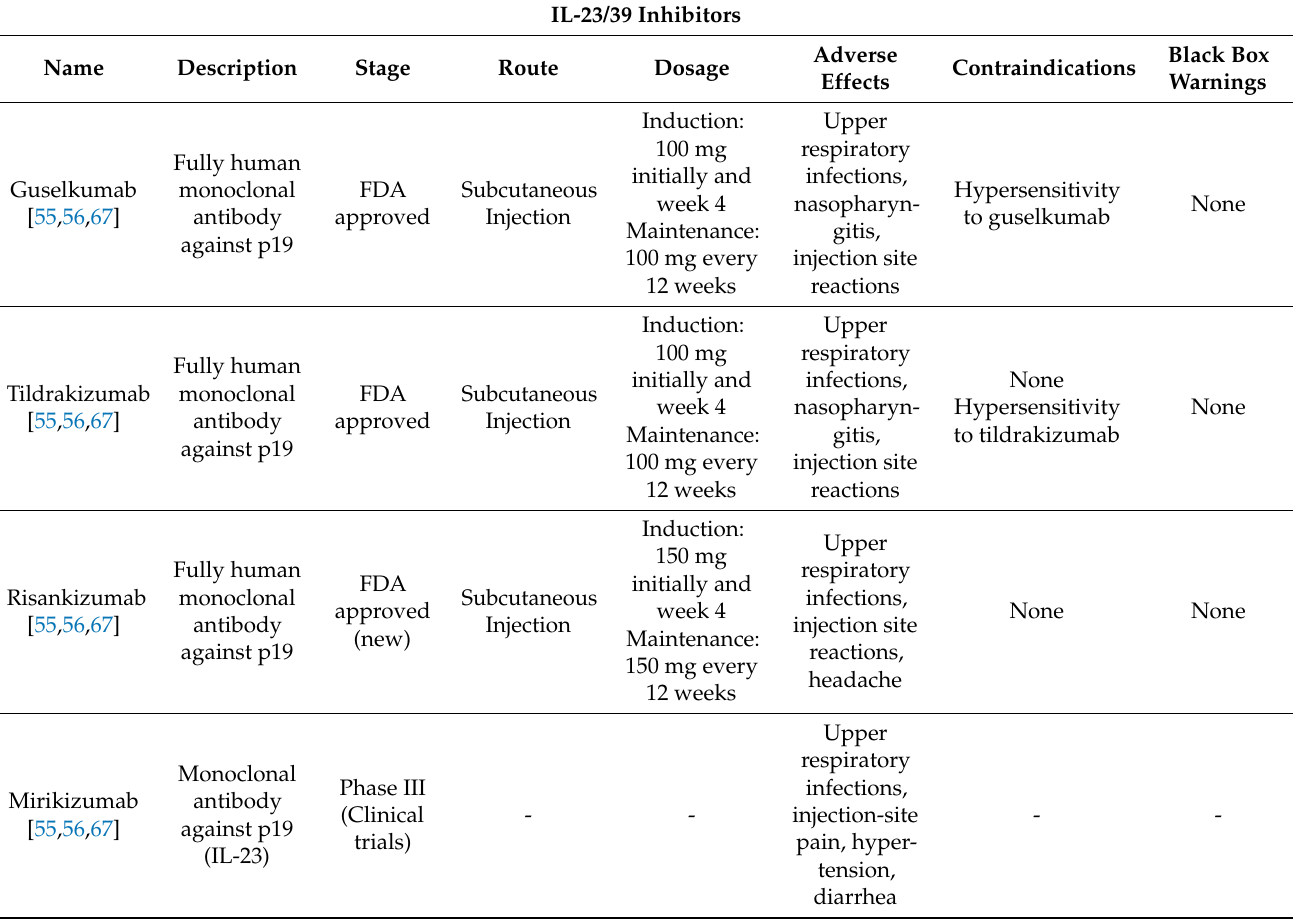
Table 5. Summary of IL-23/39 Inhibitors. IL-23/39